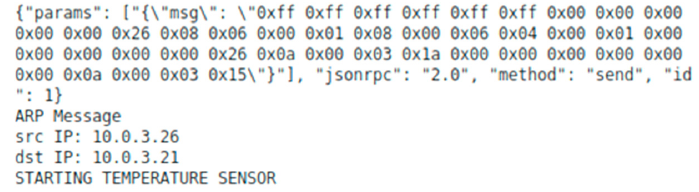
Figure 4. Exchanged message in JSON format from the controller to the broker.